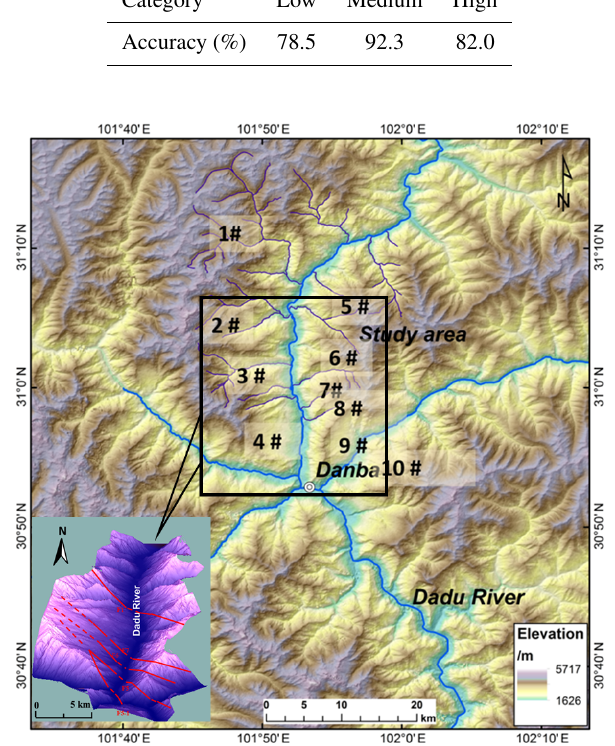
Figure 6. Residual distribution in the regression model of debris flow susceptibility.